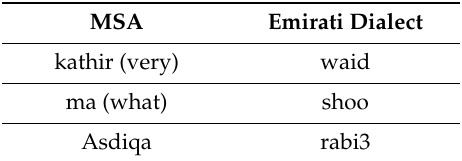
Table 2. Words that are completely di ff erent in the two versions.